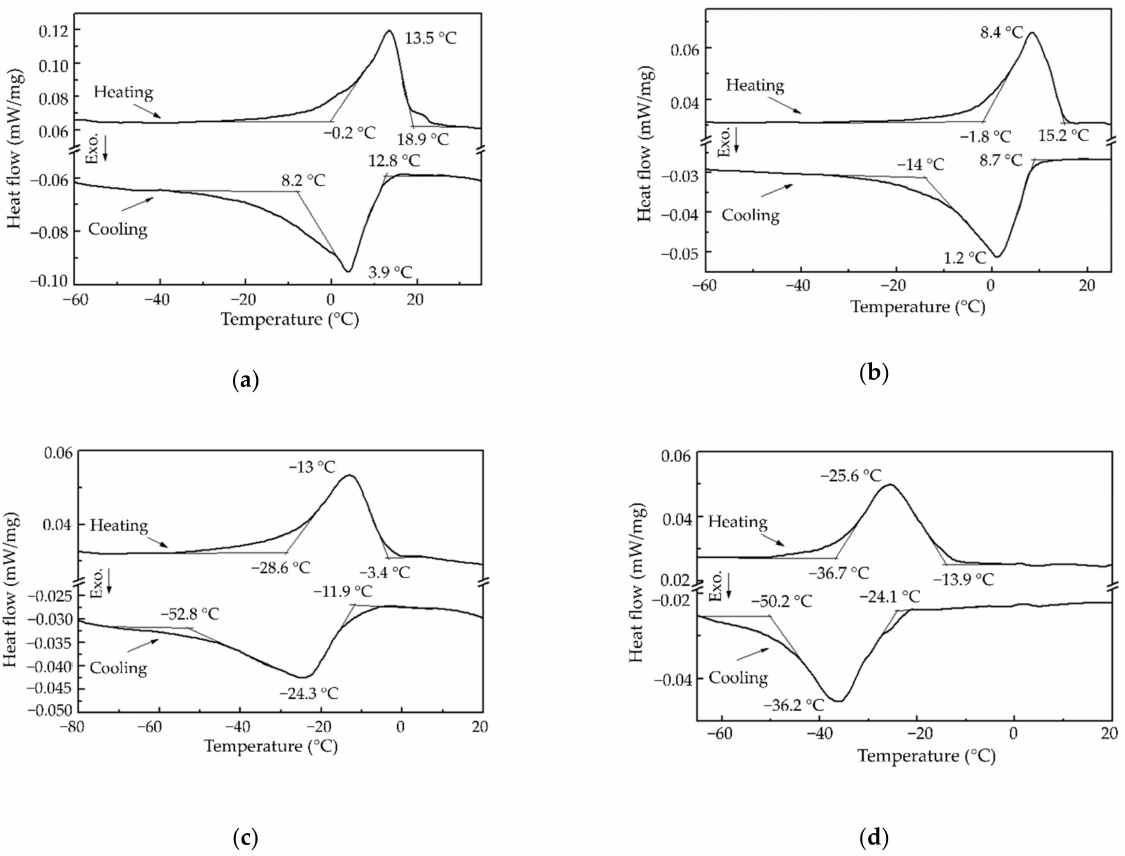
Figure 8. DSC curves of ausforming-treated alloy with true strain: ( a ) 0; ( b ) 20%; ( c ) 98%; ( d ) 151%.